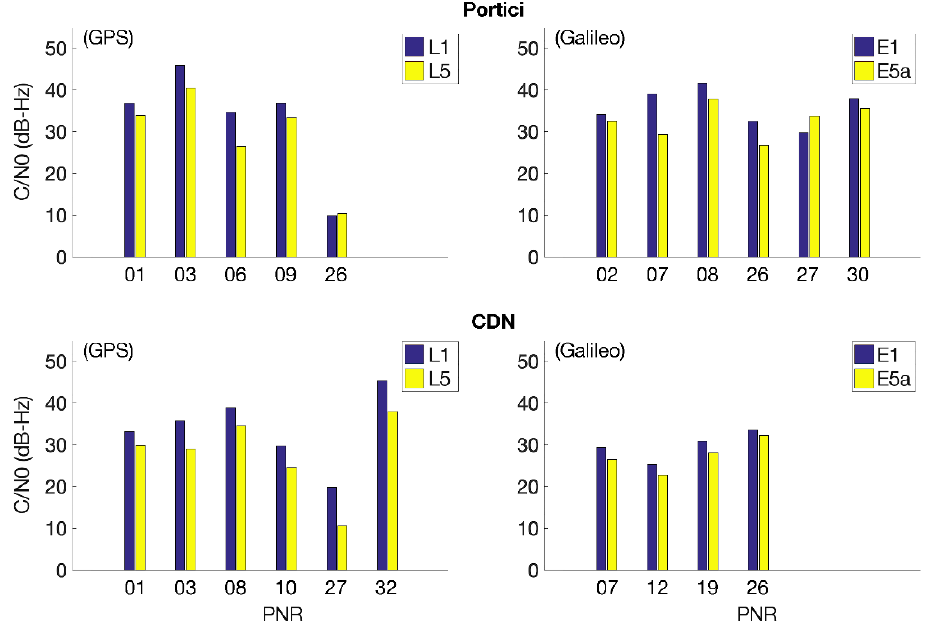
Figure 4. Mean of C/N0 values on L1/E1 L5/E5a frequency comparison. Purple bars represent L1/E1 frequency, yellow L5/E5a: top rows depict GPS and Galileo satellites in Portici site; bottom rows depict GPS and Galileo satellites in CDN site.